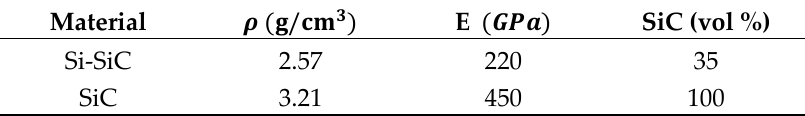
Figure 2. ( a ) FEM simulation and measurement of the frequency response of the transducer; ( b ) (I) The measured receiving frequency response of the transducer in communication with another transducer and (II) the beam pattern of the transducer, measured in the perpendicular plane to the surface of the piezoelectric elements. Table 1. Properties of fabricated Si-SiC material and pure